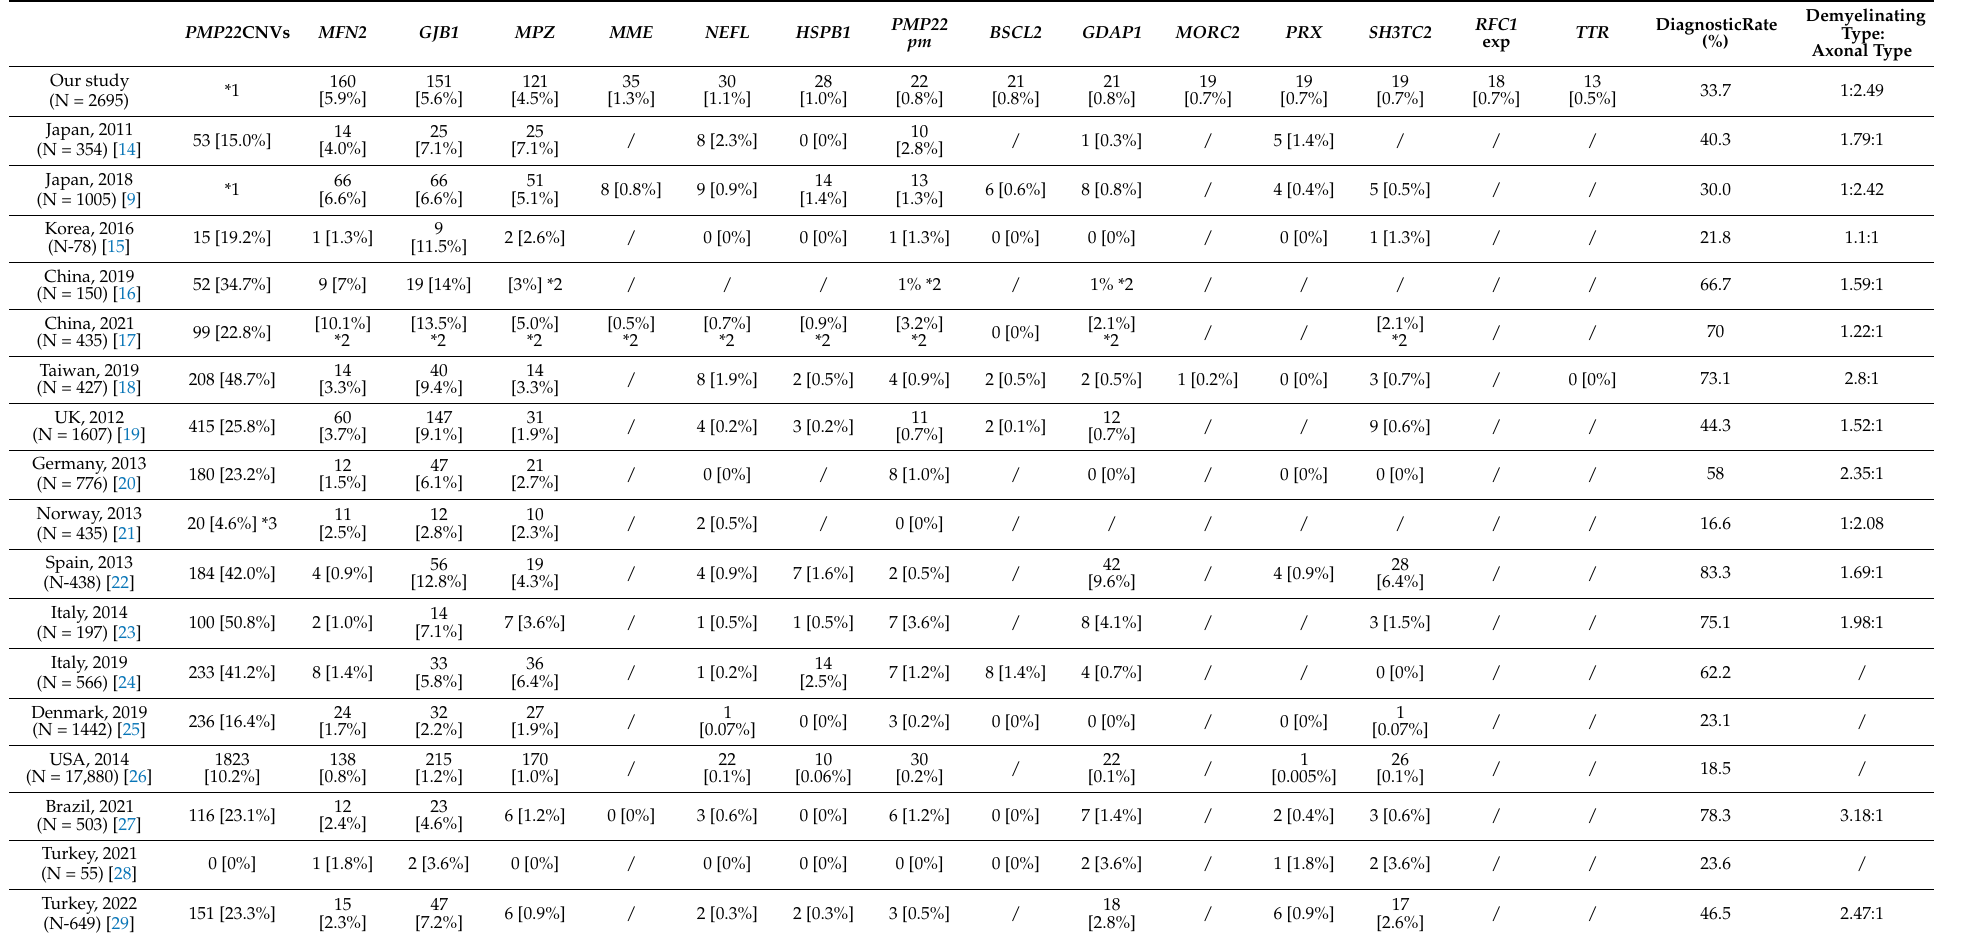
Table 2. Comparison of current and previous studies on diagnostic rate and genetic proportion of common IPN-related